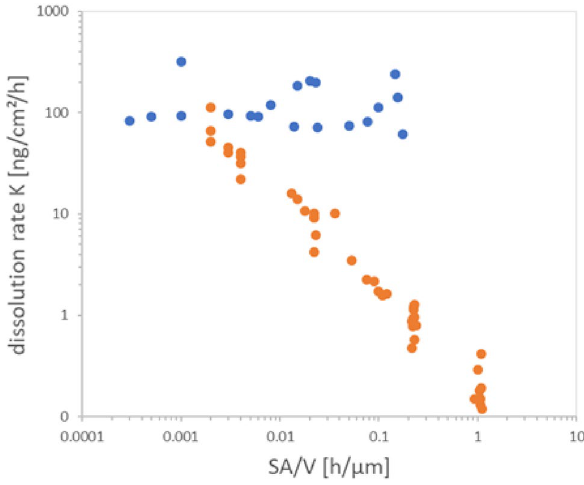
Figure 1. Instantaneous rate evaluation of biodissolution of BaSO 4 in flow-through cells with pH 4.5 PSF media. Each cloud of stepwise rates stems from separate experiment of initial mass M 0 and volume flow V. Five experiments for BaSO 4 (orange) and two for CuO (black). See Table 2 for conventional evaluation (cumulative rates) of the same raw